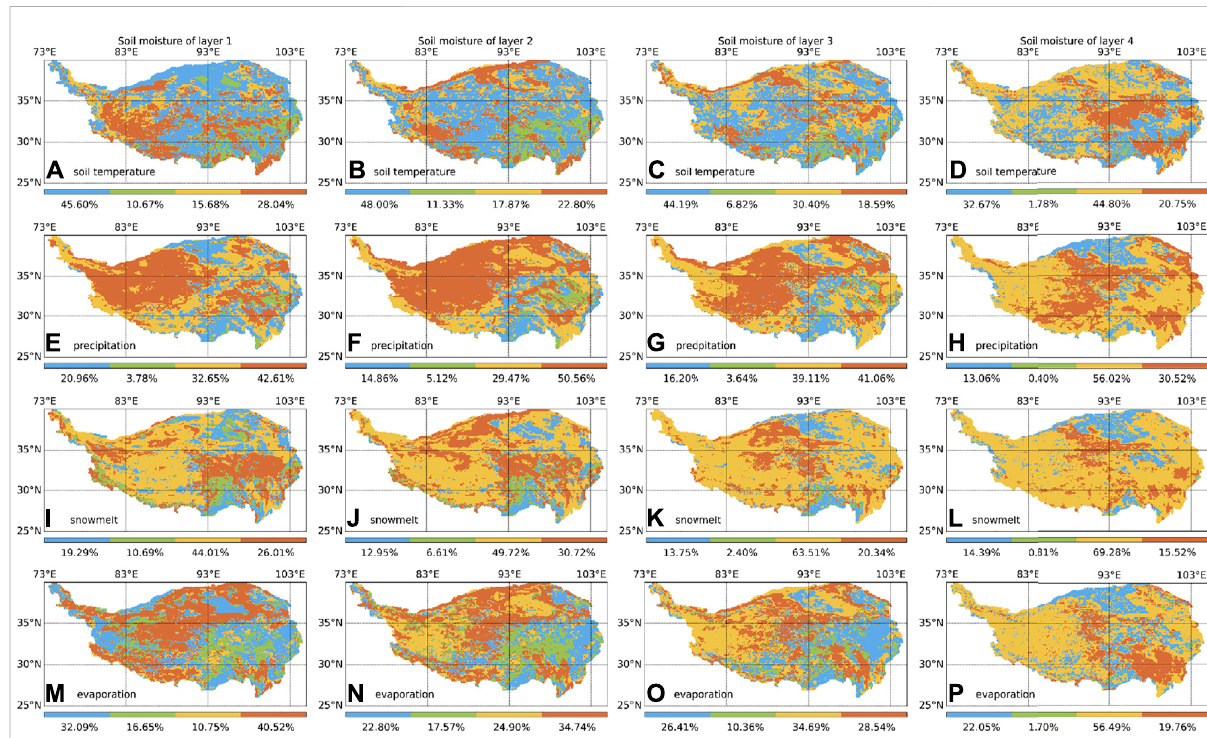
FIGURE 11 Spatial distribution of Granger causality between soil temperature, precipitation, snowmelt, evaporation, and soil moisture in layer 1 (A , E , I , M) , layer 2 (B , F , J , N) , layer 3 (C , G , K , O) , and layer 4 (D , H , L , P) . The red areas indicate bidirectional causality relationships between the soil moisture and relatedclimateparameters;yellowindicatesthattherelatedclimateparametersaretheunidirectionalcauseofthesoilmoisture;greenindicatesthat the soil moisture is the unidirectional cause of the related climate parameters. Areas without signi fi cant causal links are shown in